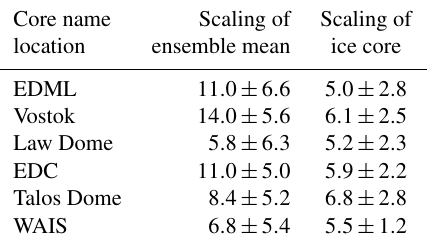
Table 4. Air temperature scaling of the precipitation for six ice core locations in Antarctica. The second column lists the ensemble mean scaling (RCP8.5, first 50 years, both the PISM1Eq and PISM2Eq initial states) and standard deviation (2 σ ) across all ensemble mem- bers. The third column provides scaling factors deduced from ice cores (Frieler et al., 2015), including the provided error margins (2 σ ). The reader is referred to Fig. 4 for the ice core